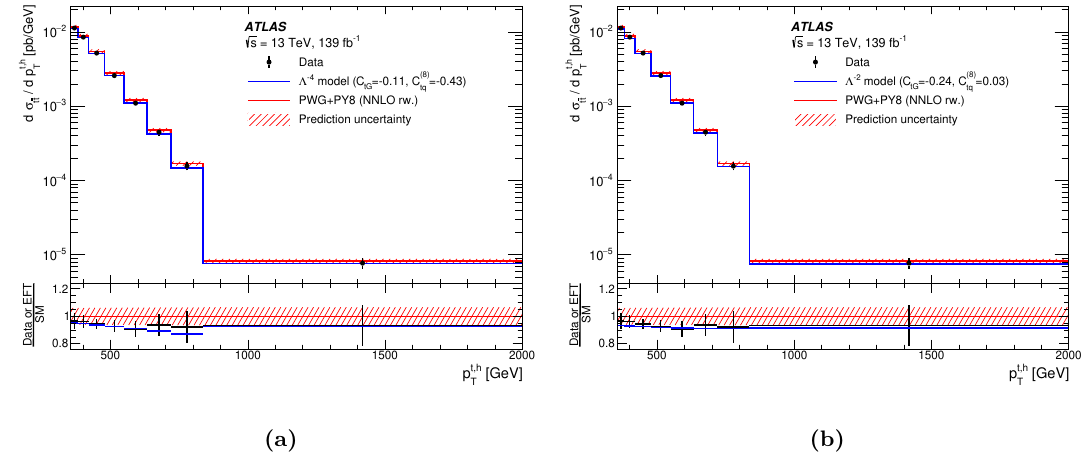
used in the EFT interpretation. The Figure 19. Differential cross-section measurement of p t,h T data are compared with the SM prediction in red and the EFT model prediction in blue at the respective global modes for (a) the Λ − 4 model and (b) the Λ − 2 model. The lower panel in each plot displays the ratio of the data or EFT model to the SM prediction. The shaded red band shows the uncertainty in the SM prediction used in the EFT fit.